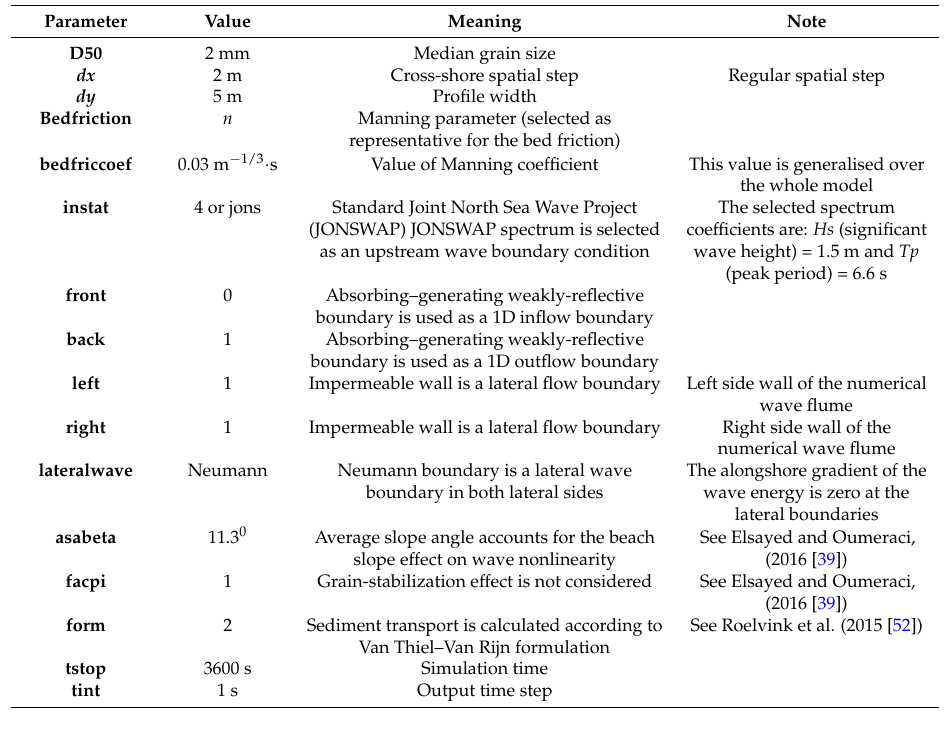
Table 1. Main parameters and boundary conditions used in the analysis of the 1D synthetic profile (Figure 1a) using XBeach.